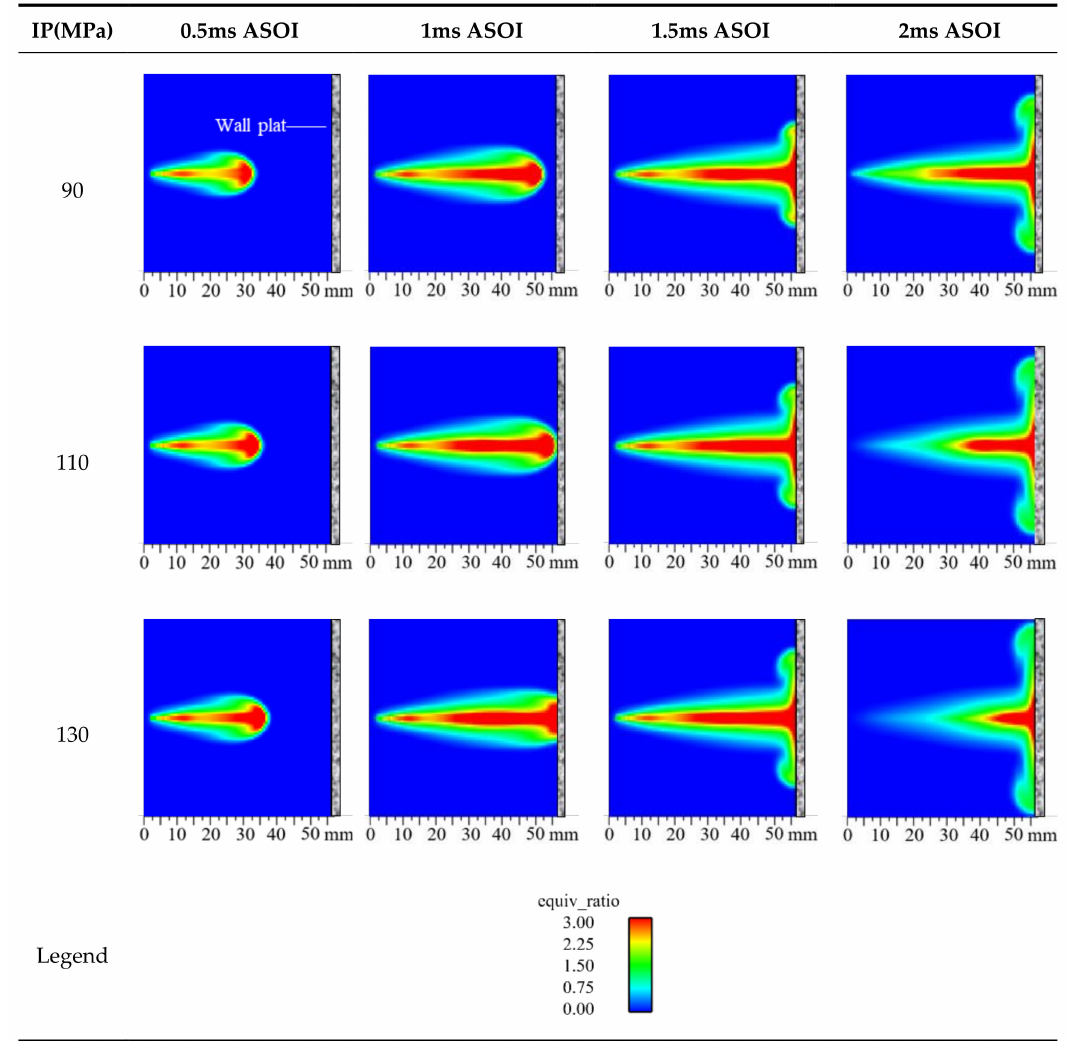
Figure 8. Simulation results of the equivalence ratio under di ff erent injection